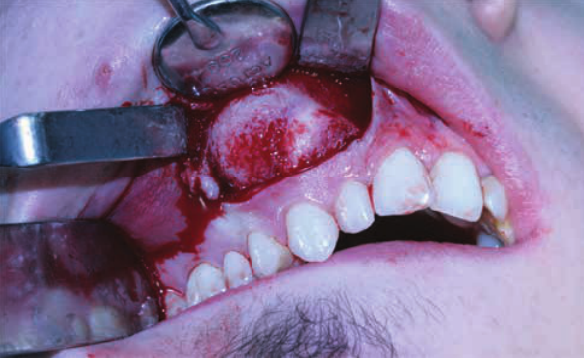
Figure 5a: Patient K. M, aged 19. Intraoperative image taken when tissue was being collected for histopathological examination.